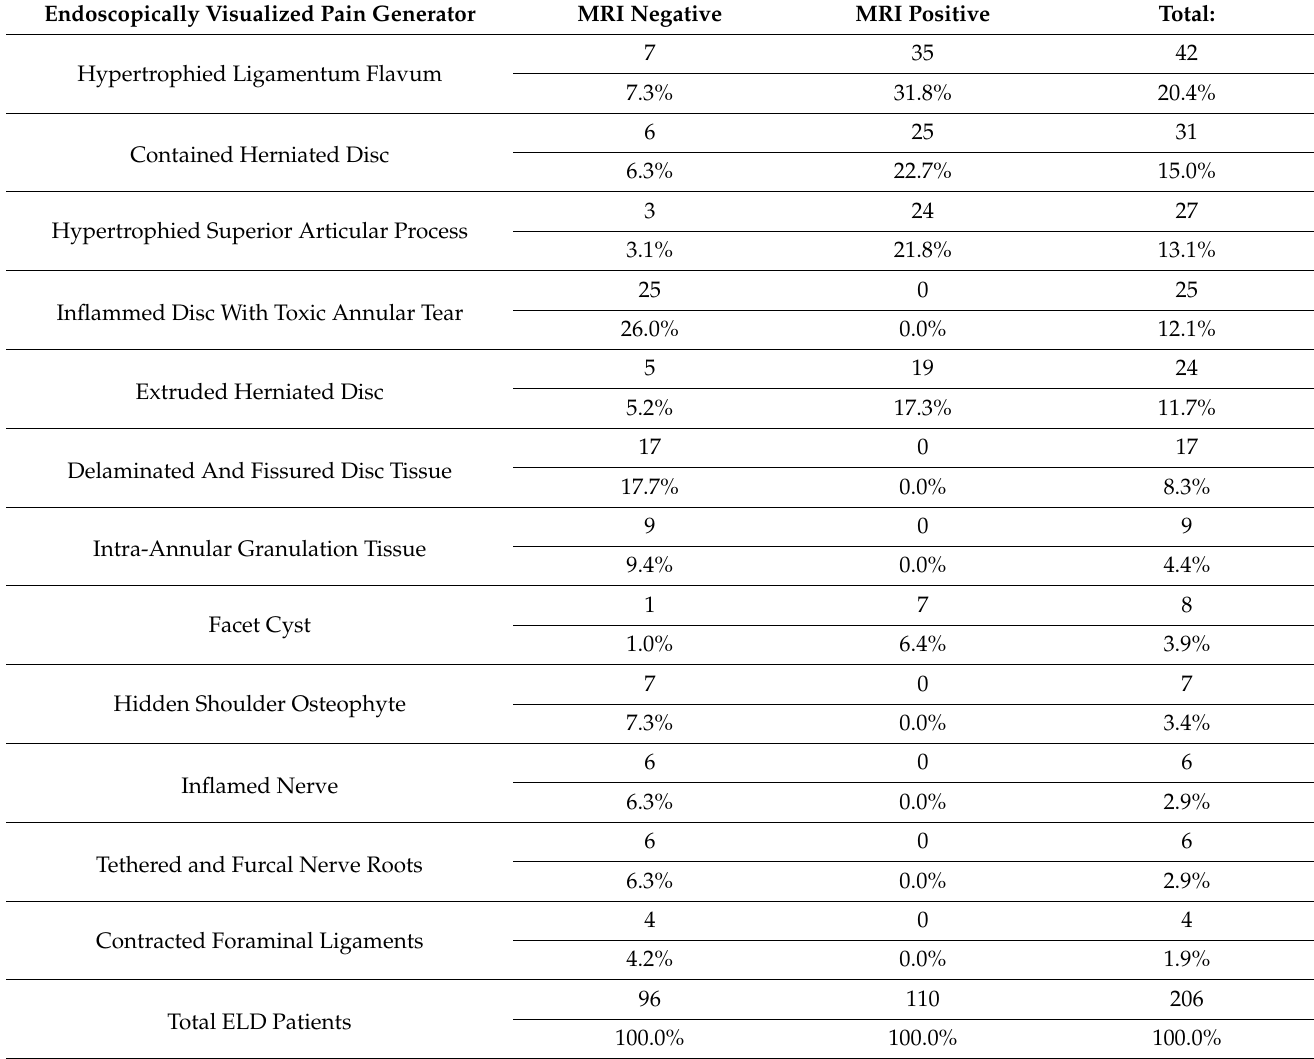
Table 2. Crosstabulation primary pain generator visualized during the endoscopic operation and their reporting on routine lumbar